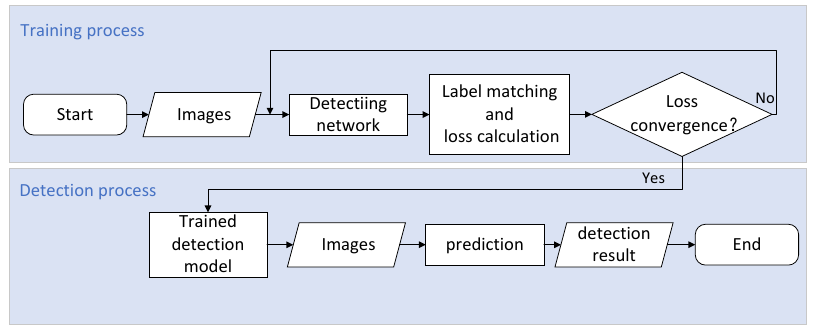
Figure 9. Vehicle logo detection